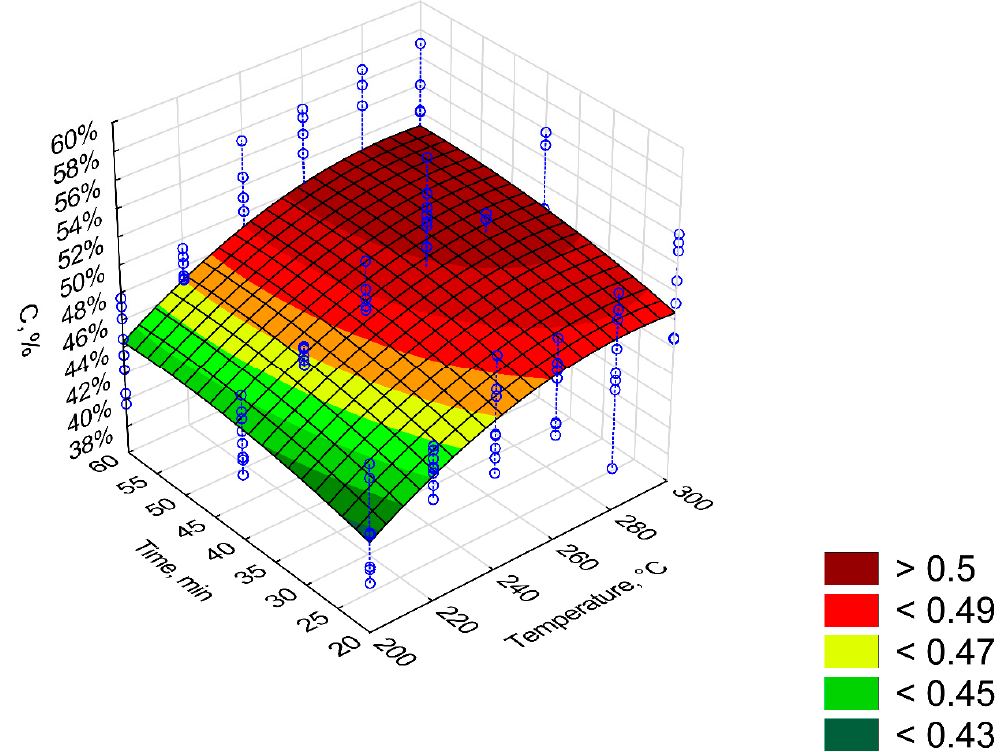
Figure 11. Visualization of 3D model of C content of torrefied pruned biomass. Table 9. Statistical evaluation of C content model of torrefied pruned biomass.